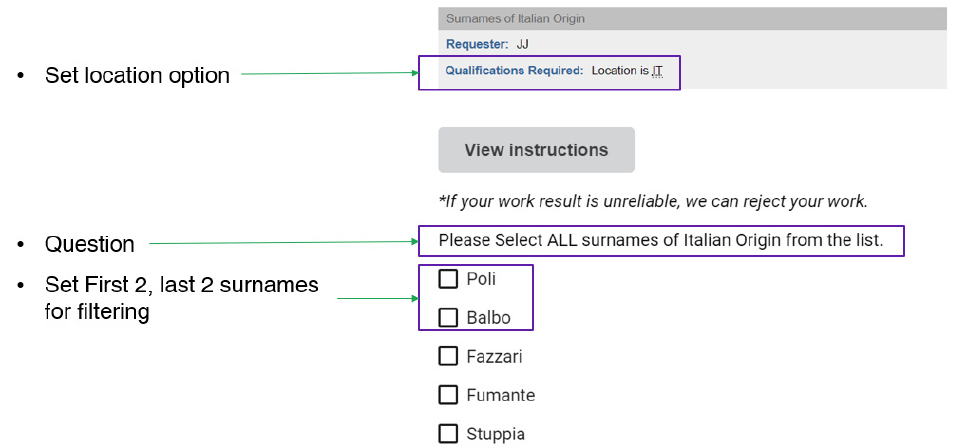
Figure 3. Request form of Mturk.